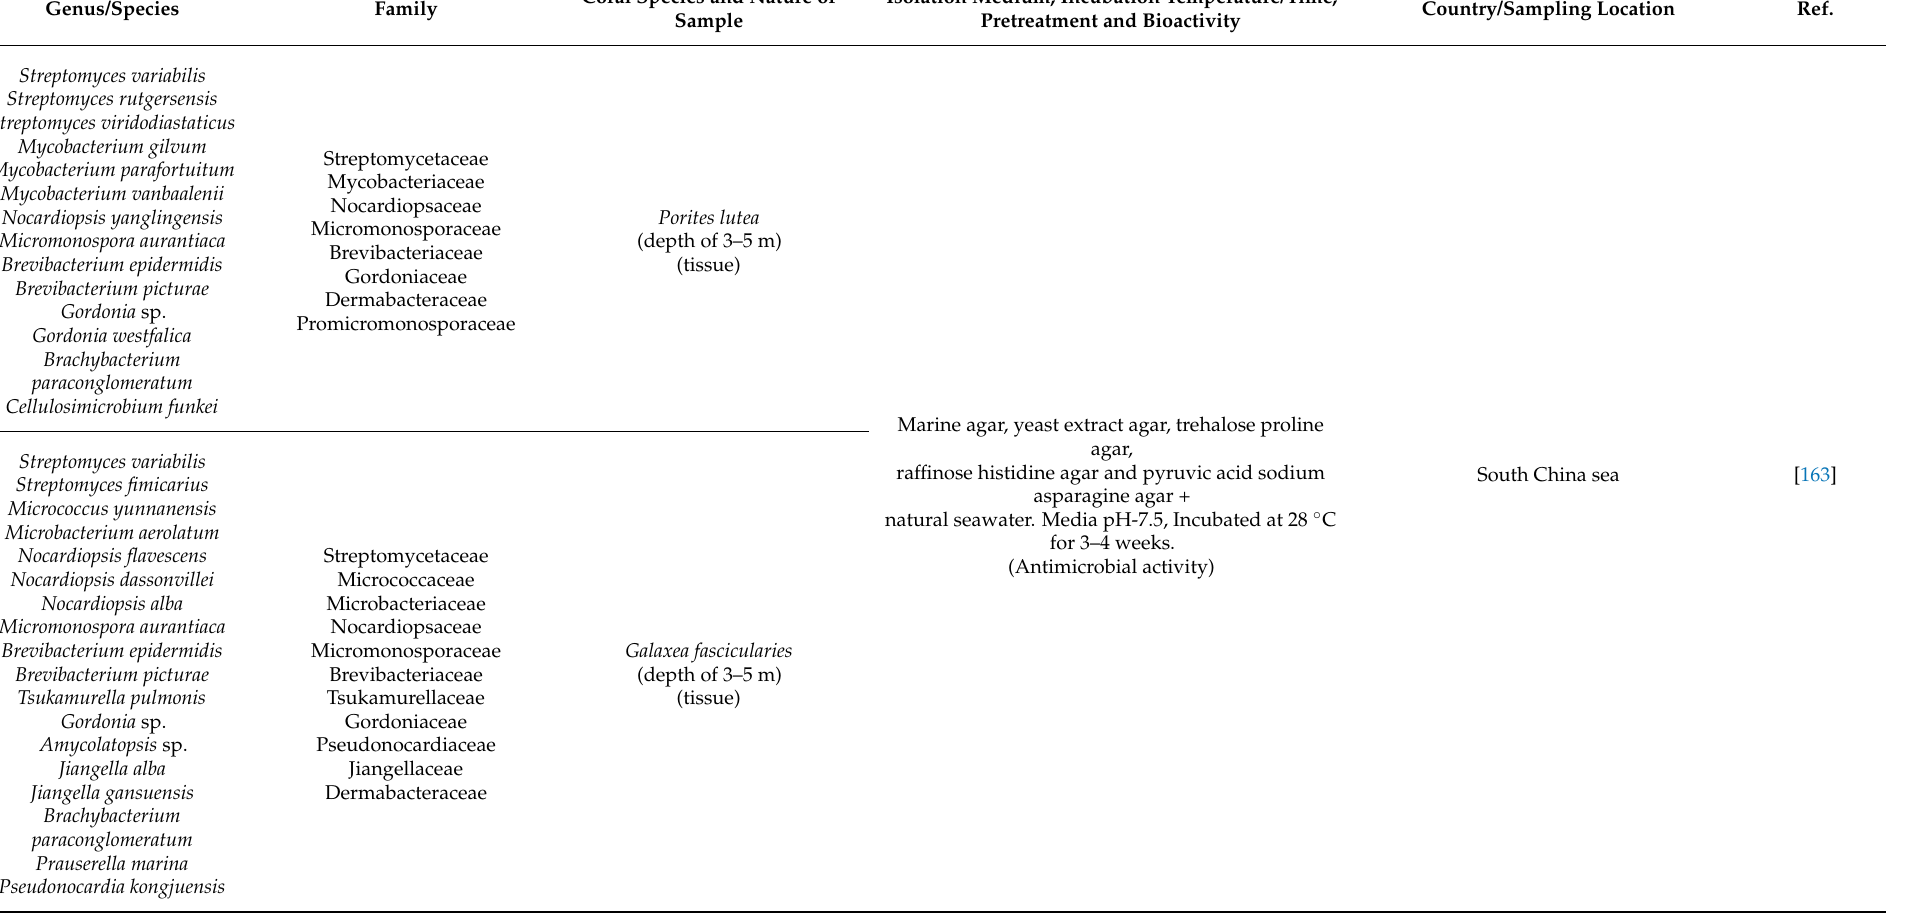
Country/Sampling Location